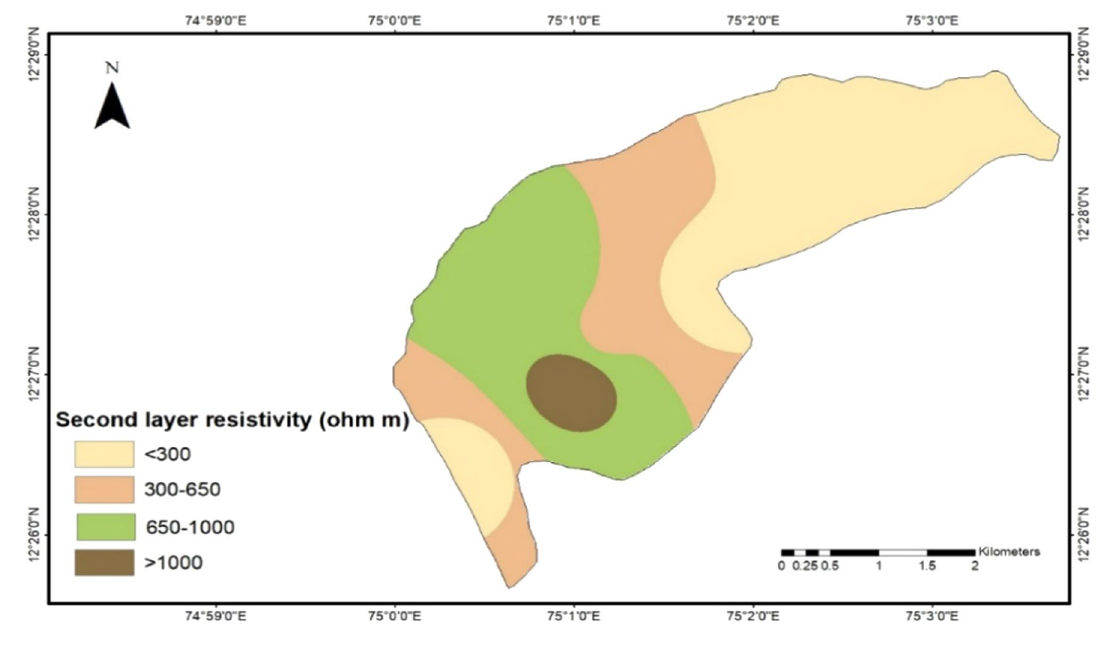
Fig. 6 Spatial variation mapof second layer apparent resistivity(ohmm)